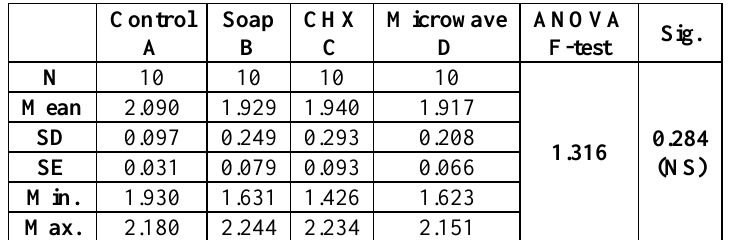
Table 4: Descriptive statistics and One-way ANOVA of Color Absorbance